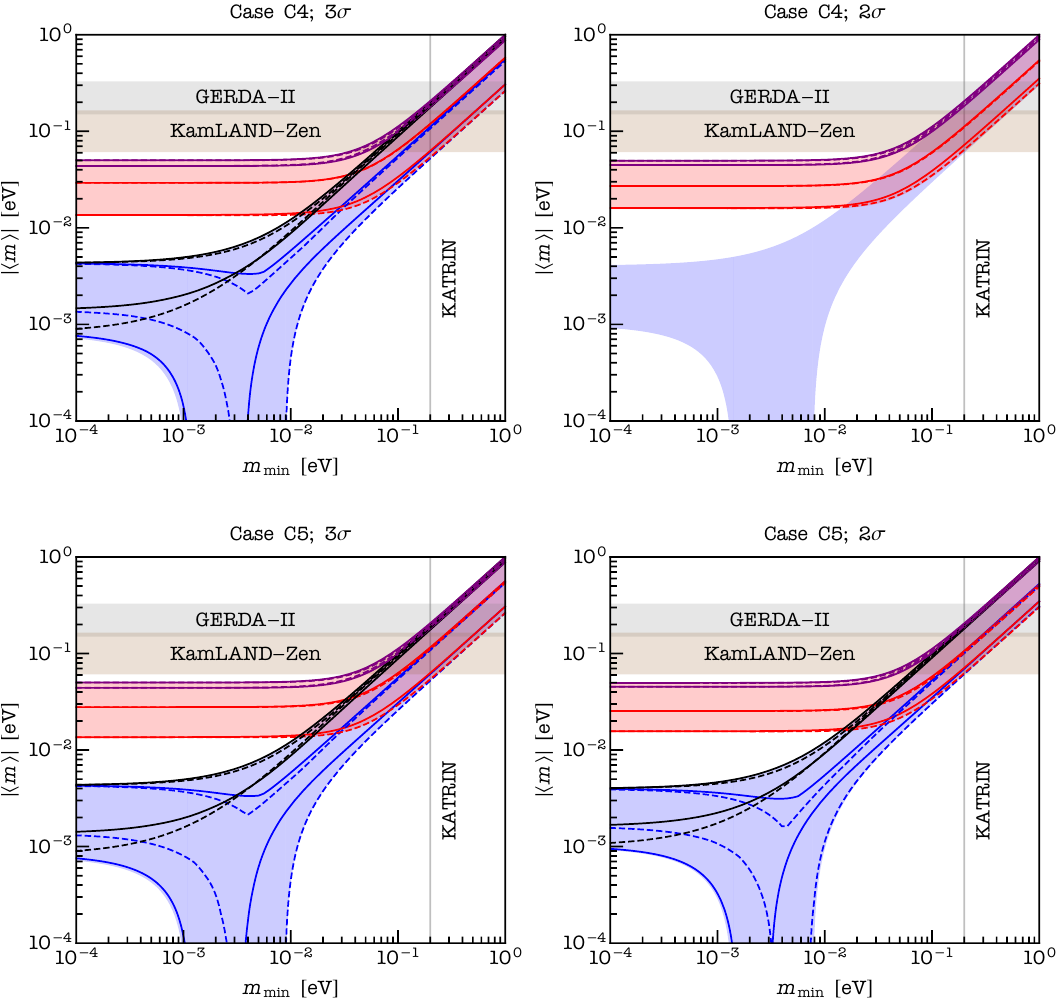
Figure 15 . The same as in (cid:12)gure 13, but for cases C4 and